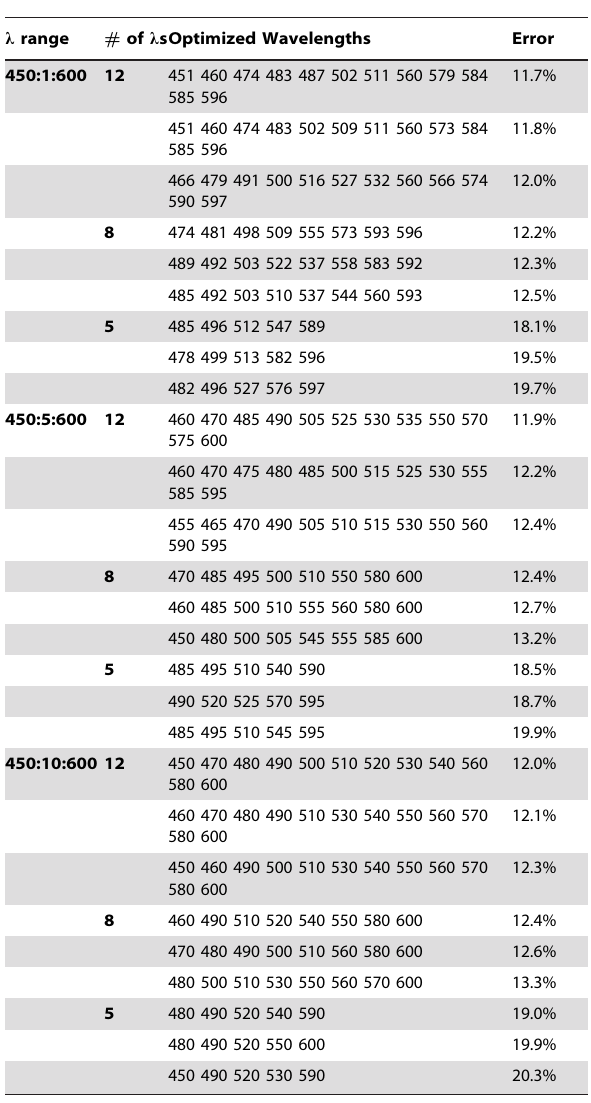
The error from the optimization is the minimized average errors of the extracted parameters from the 15 representative reflectance spectra chosen from the breast tissue data set.